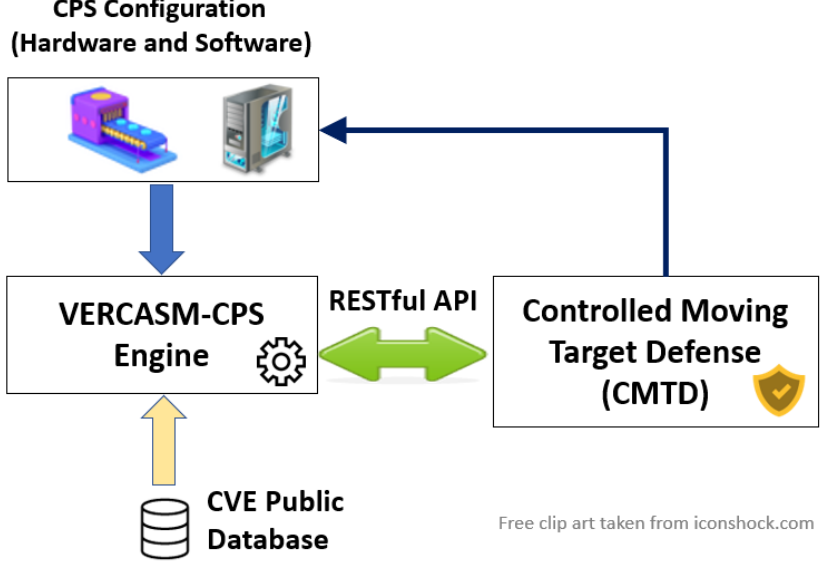
Figure 4. Integration between VERCASM-CPS Engine and Controlled Moving Target